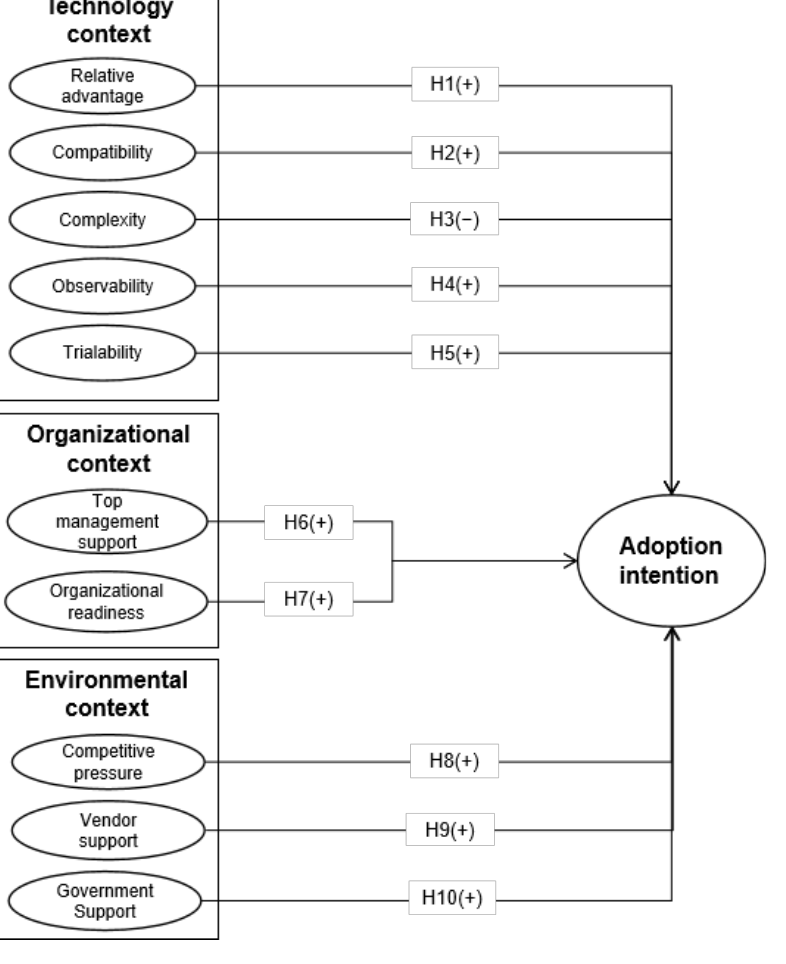
Figure 1. Research